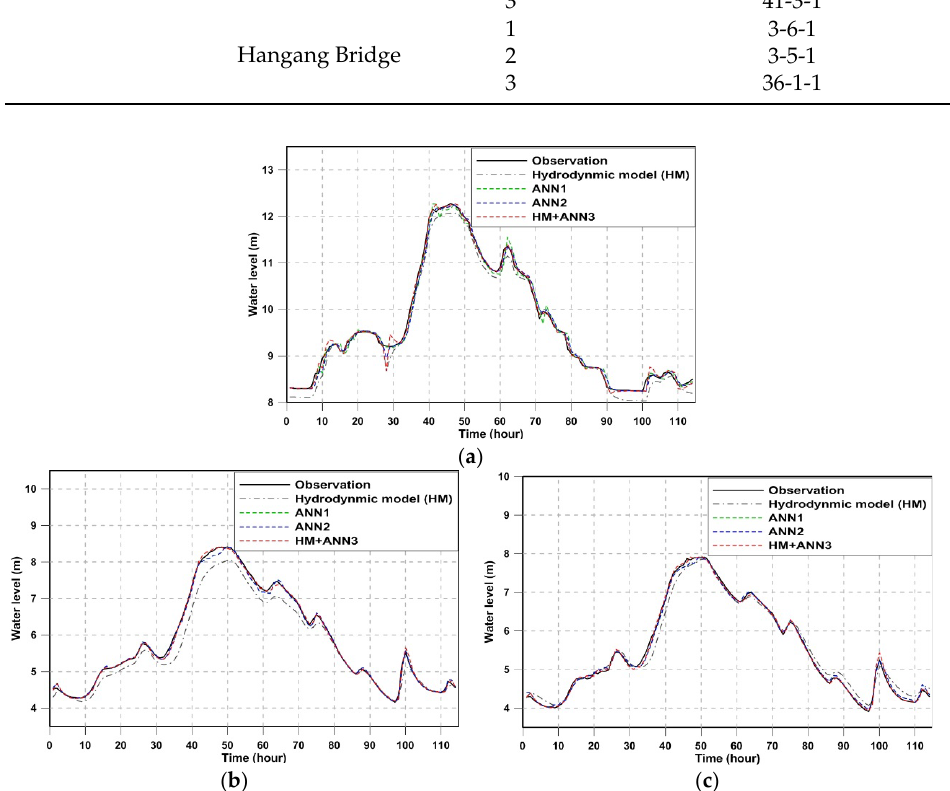
Figure 10. One-hour lead time water levels calculated by various forecasting models for flood event 2 (15 July 2004–19 July 2004): ( a ) Paldang Bridge; ( b ) Banpo Bridge; ( c ) Hangang Bridge.